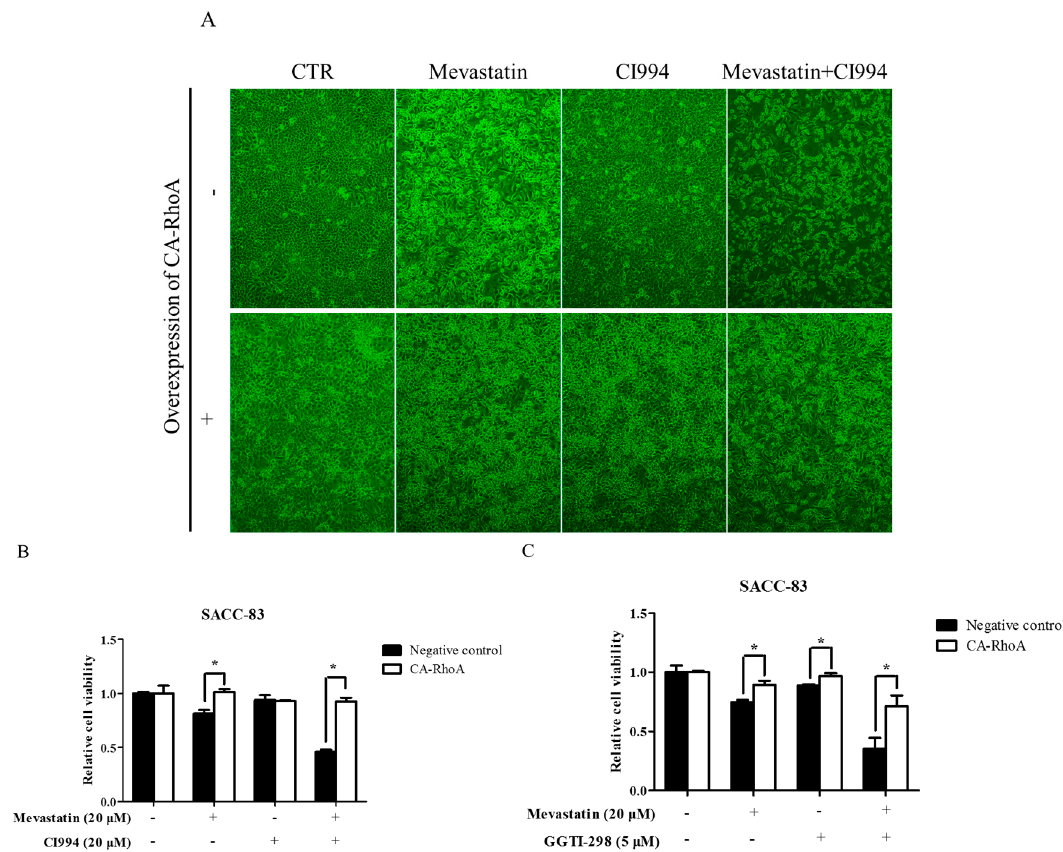
Figure 6. Overexpression of constitutively active RhoA abolished enhancement by HDAC1 or GGTase-I inhibitor of statin-induced anti-cancer effects. SACC-83 cells stably transfected with constitutively active RhoA or not were exposed to either mevastatin, or CI994, or both for 48 h. ( A ) Microphotographs after treatment (10 × ); ( B ) cell viability assessed by CCK8 assay; ( C ) SACC-83 cells stable transfected with constitutively active RhoA or not were exposed to either mevastatin, GGTI-298, or both for 48 h. Cell viability was assessed by CCK8 assay. * P < 0.05, n = 4.